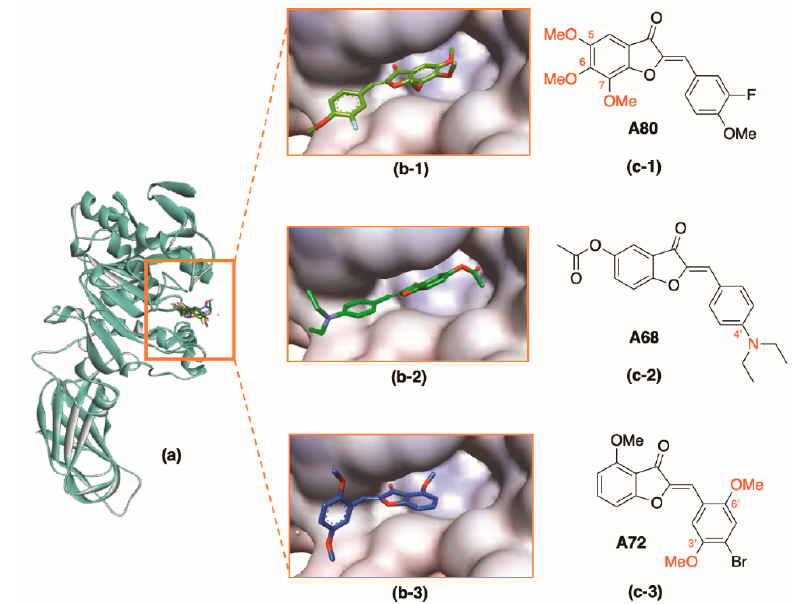
Figure 8. Some compounds of Group II in lipase (PDB ID: 1LPB) active site: ( a ) A80 , A68 , and A72 inside the active site in the ribbon style. ( b ) A80 , A68 , and A72 inside the active site. ( c ) 2D structures of A80 , A68 , and A72 .